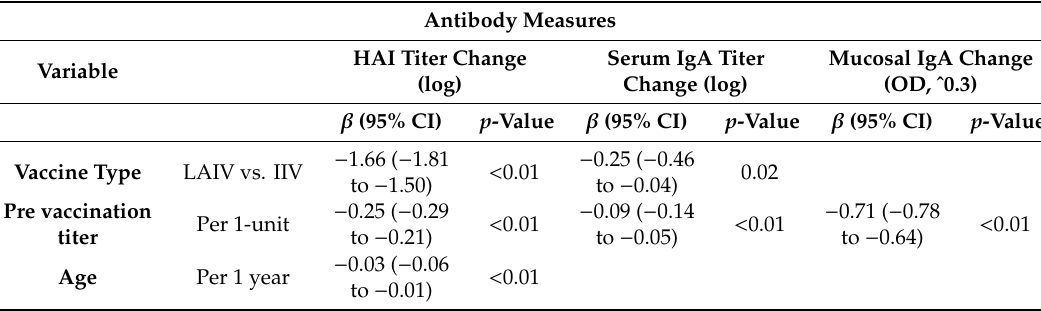
Table 2. Variables associated with antibody response to A / California / 07 / 2009-like